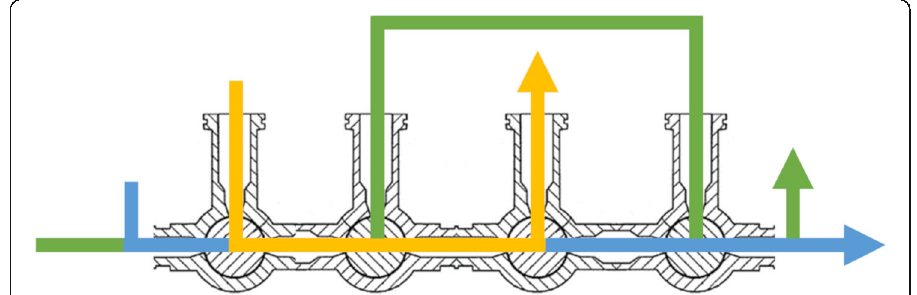
Fig. 1 Cross section of single fluid bus consisting of a typical row of stopcock valves – the colored lines represent different fluid paths that cross each other and therefore will contaminate each other with residual